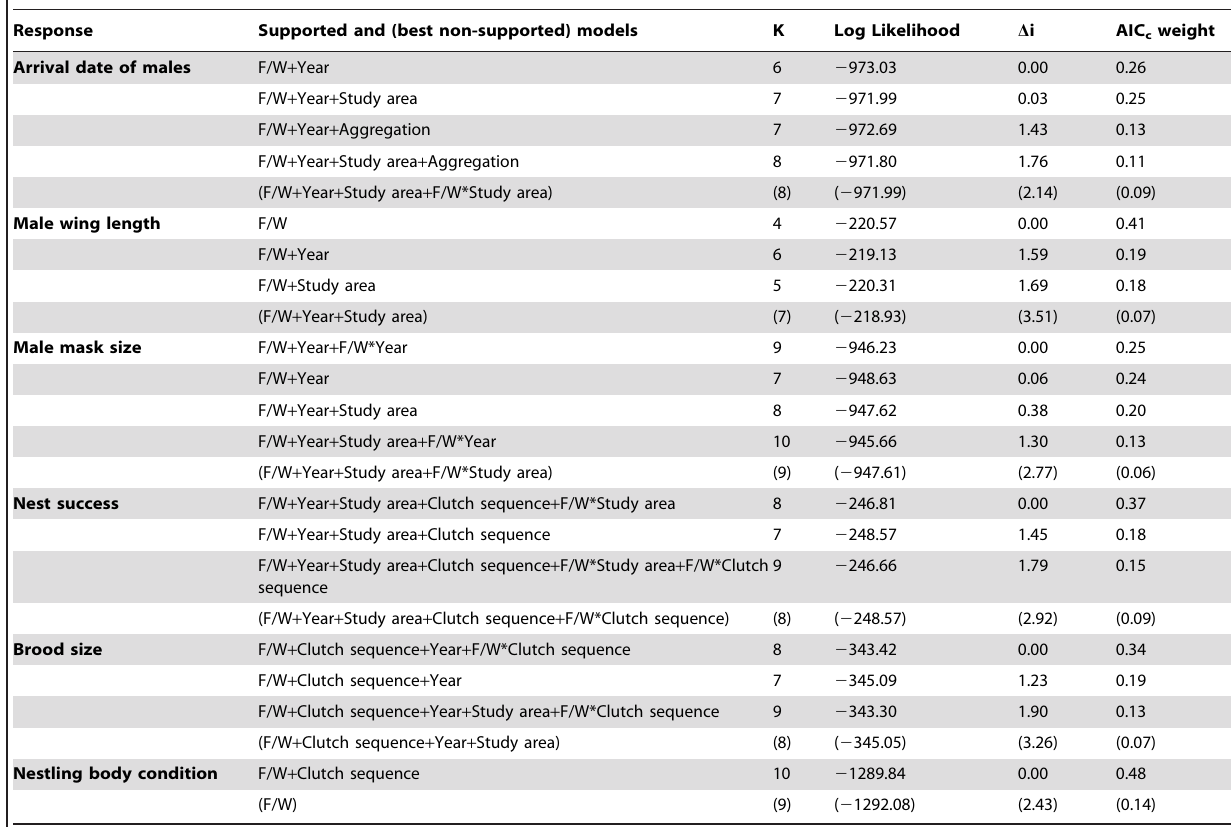
Table 1. Set of supported ( D i , 2) and best non-supported ( D i . 2, between brackets) models for habitat preference (arrival date, wing length and mask size of males) and reproductive performance (nest success, brood size and nestling body condition) measures along with their respective support (AIC c